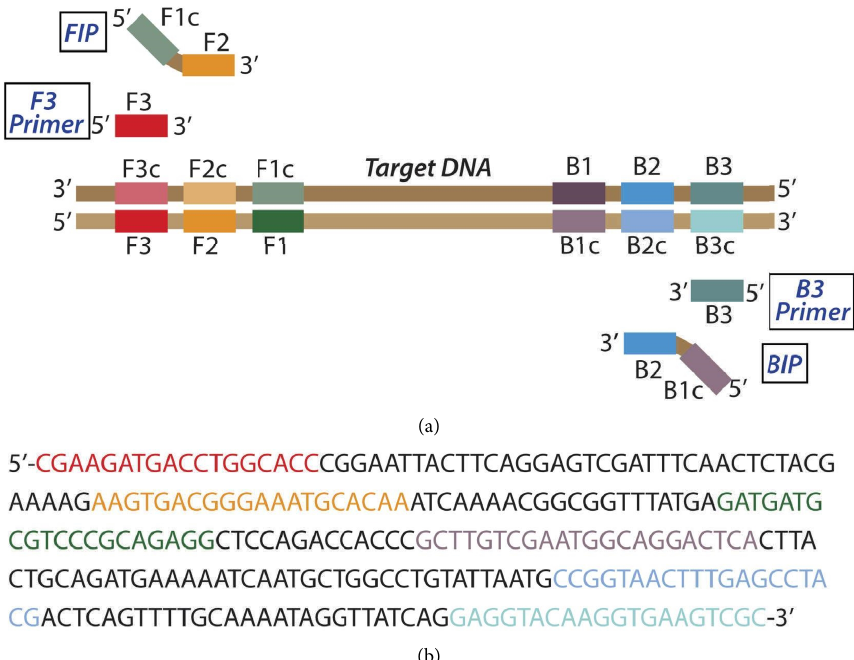
Figure 2: (a) LAMP primer design. Six distinct regions are designated on the target DNA, labeled F3, F2, F1, B1c, B2c, and B3 from the 5 ′ end. Te F1c sequence is complementary to the F1 sequence. Two inner primers (FIP and BIP) and two outer primers (F3 and B3) are used in the LAMP method. FIP (BIP) is a hybrid primer consisting of the F1c (B1c) sequence and the F2 (B2) sequence. (b) LAMP primer mapping. Te portion of the SopD gene that is targeted by the developed Salmonella enterica QUASR LAMP assay is shown here. Te colored nitrogenous bases show the corresponding LAMP primer in Figure 2(a).